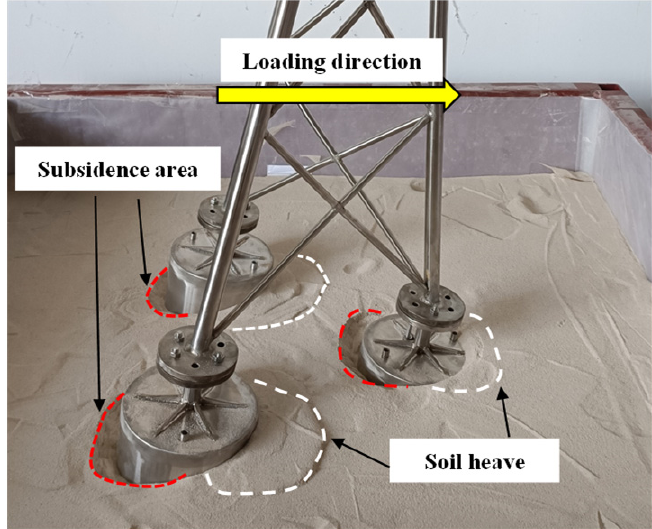
Figure 9. Failure mode of test